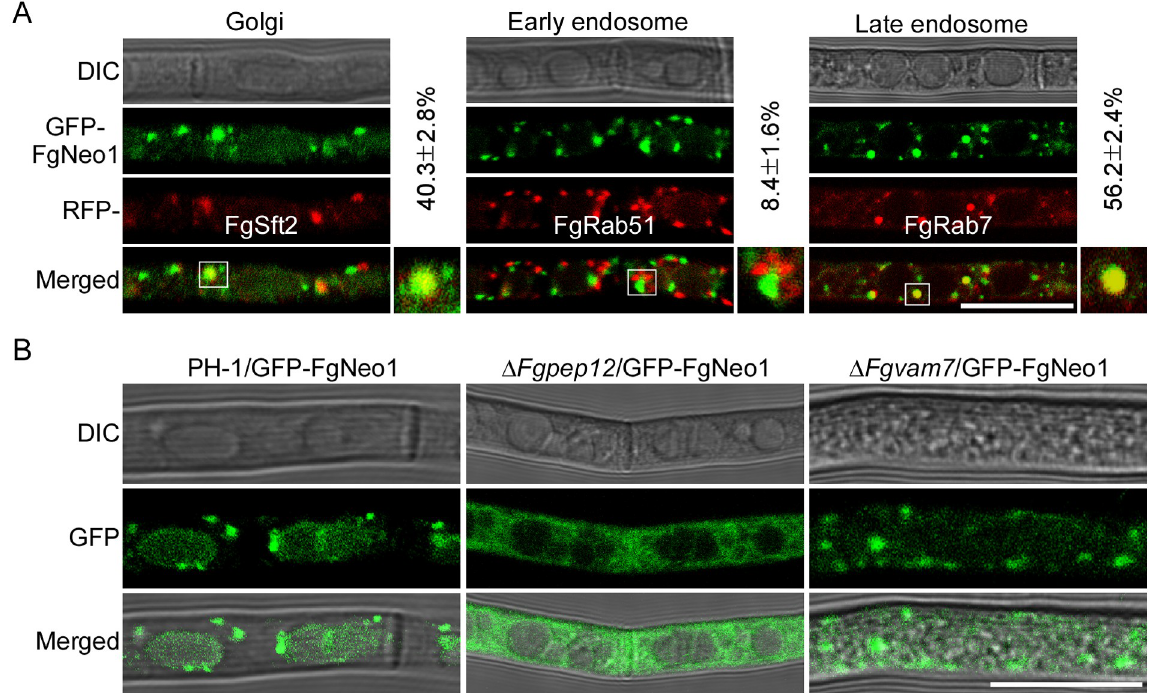
Fig 10. FgNeo1 localizes to late endosomes and Golgi apparatus that regulated by FgPep12. (A) Expression and localization of GFP- FgNeo1 in F . graminearum . Hyphae of transformants co-expressing GFP-FgNeo1&FgSft2-RFP, GFP-FgNeo1&RFP-FgRab51 or GFP-FgNeo1&RFP-FgRab7 constructs were examined under a confocal microscope. Numbers indicate the merged rate of both proteins. Bar = 10 μ m. (B) Hyphae of transformants expressing GFP-FgNeo1 in the wild type PH-1, Δ Fgpep12 and Δ Fgvam7 mutants were examined by DIC or fluorescence microscope. Bar = 10 μ